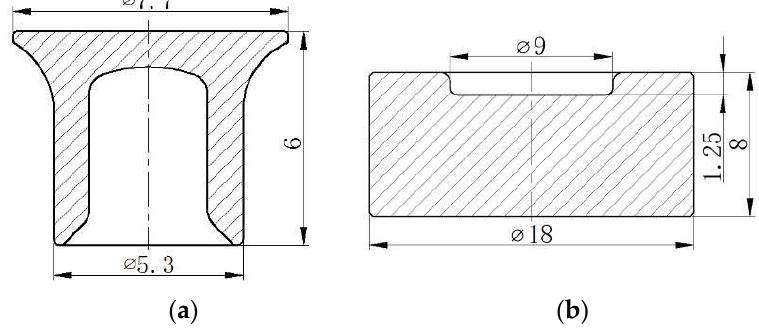
Figure 3. Dimensions of the rivet and the die (dimensions in mm): ( a ) Rivet; ( b ) Die.